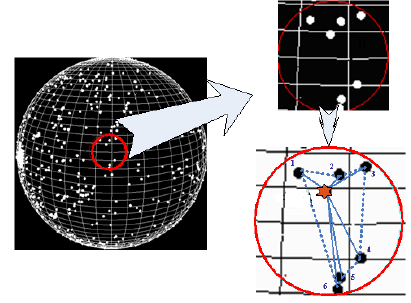
Figure.1. Star Extraction and pattern Construction.